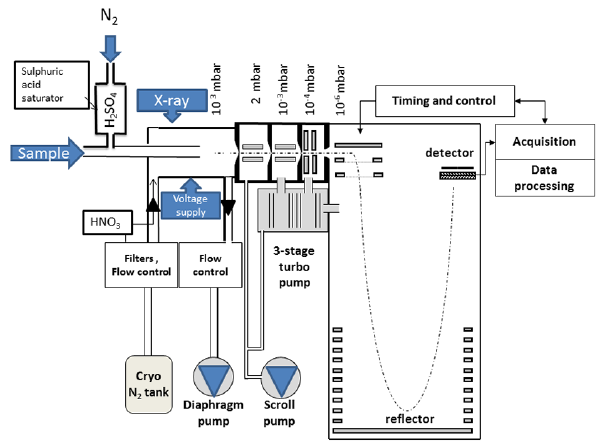
Figure 1. Schematic of the bisulfate – cluster chemical ionization atmospheric pressure interface time-of-flight mass